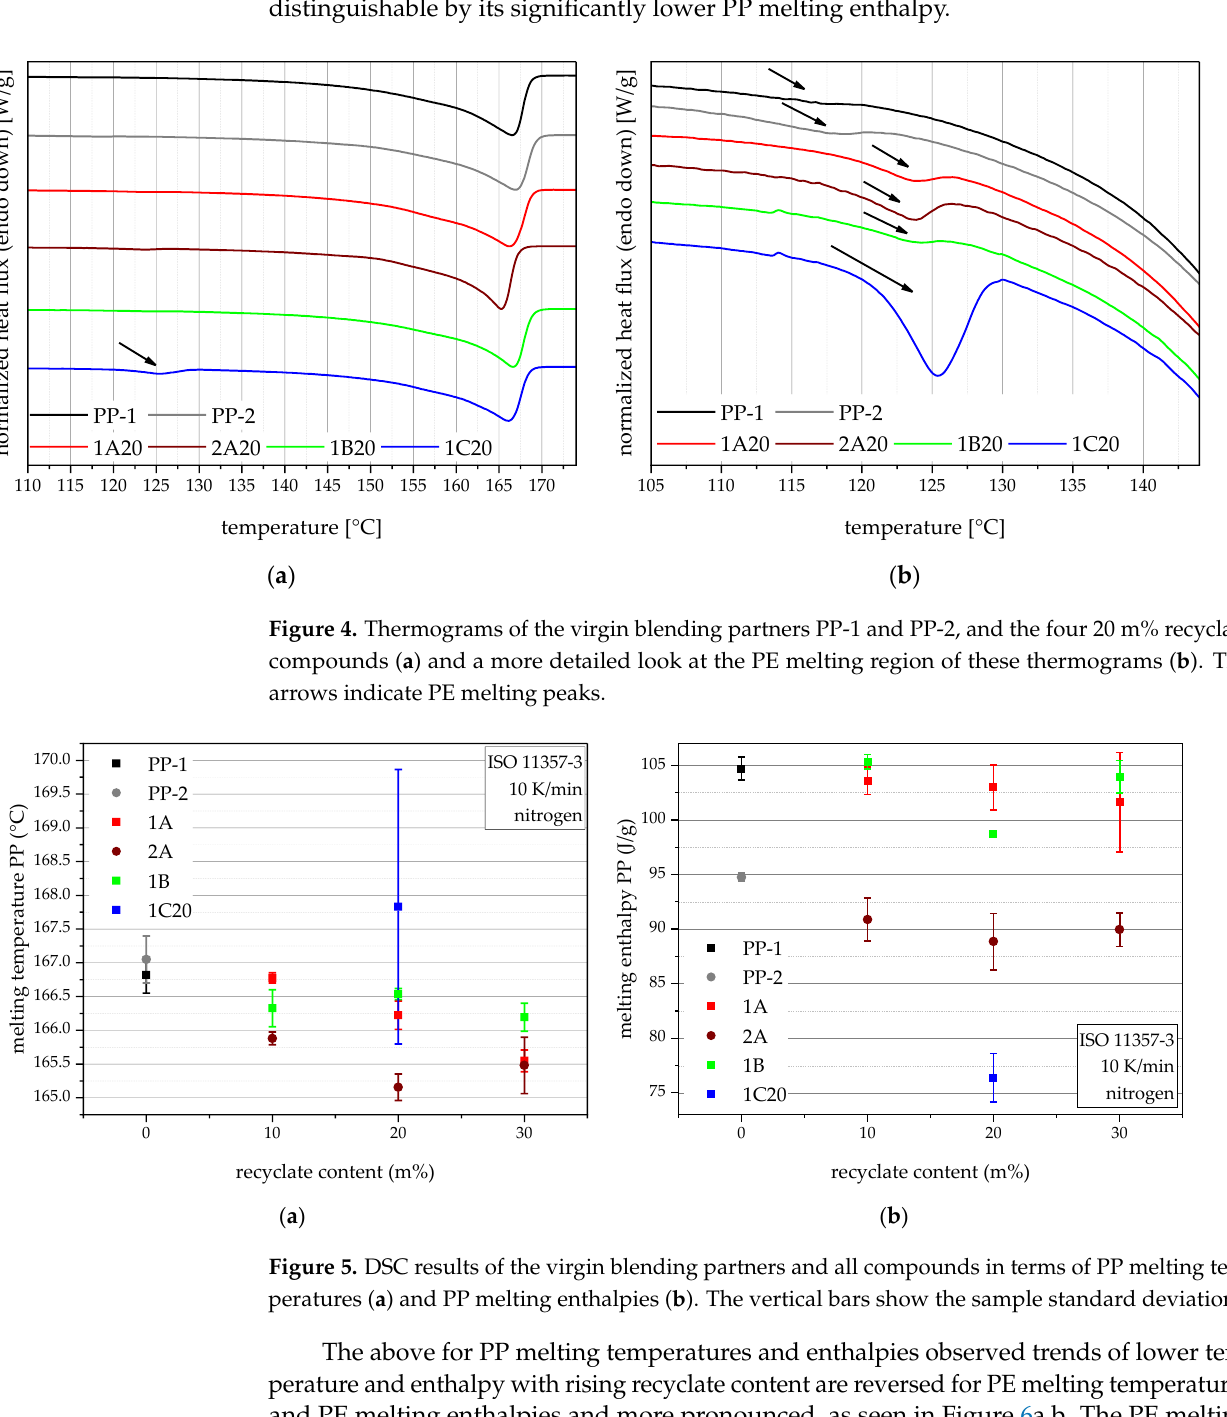
Figure 5. DSC results of the virgin blending partners and all compounds in terms of PP melting tem- peratures ( a ) and PP melting enthalpies ( b ). The vertical bars show the sample standard deviations.